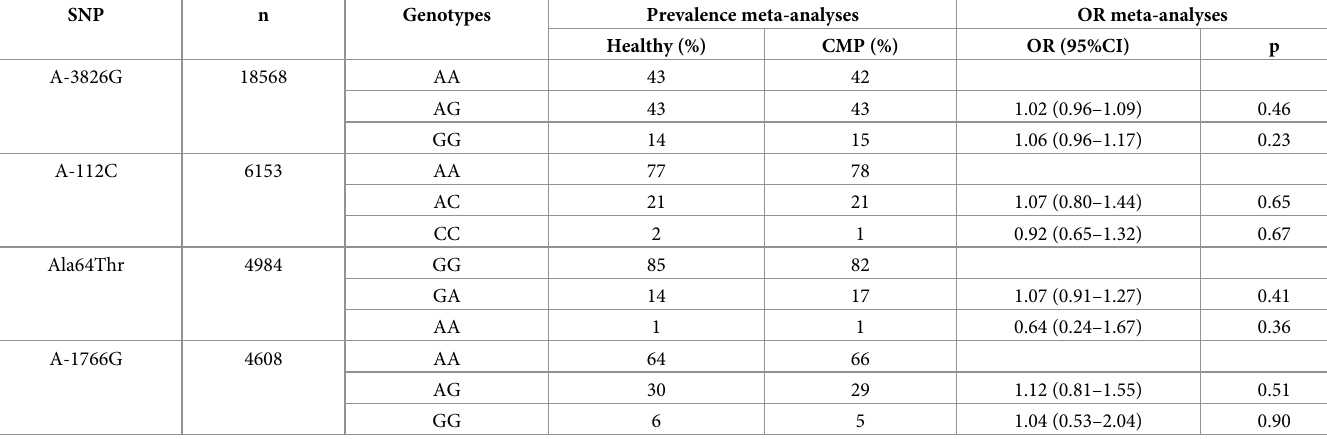
Key: CMP = cardio-metabolic pathologies; n = number of studied individuals; OR = odds ratio with reference to AA; 95%CI = 95% confidence intervals; p = p value for the Z test indicating the overall effect in the